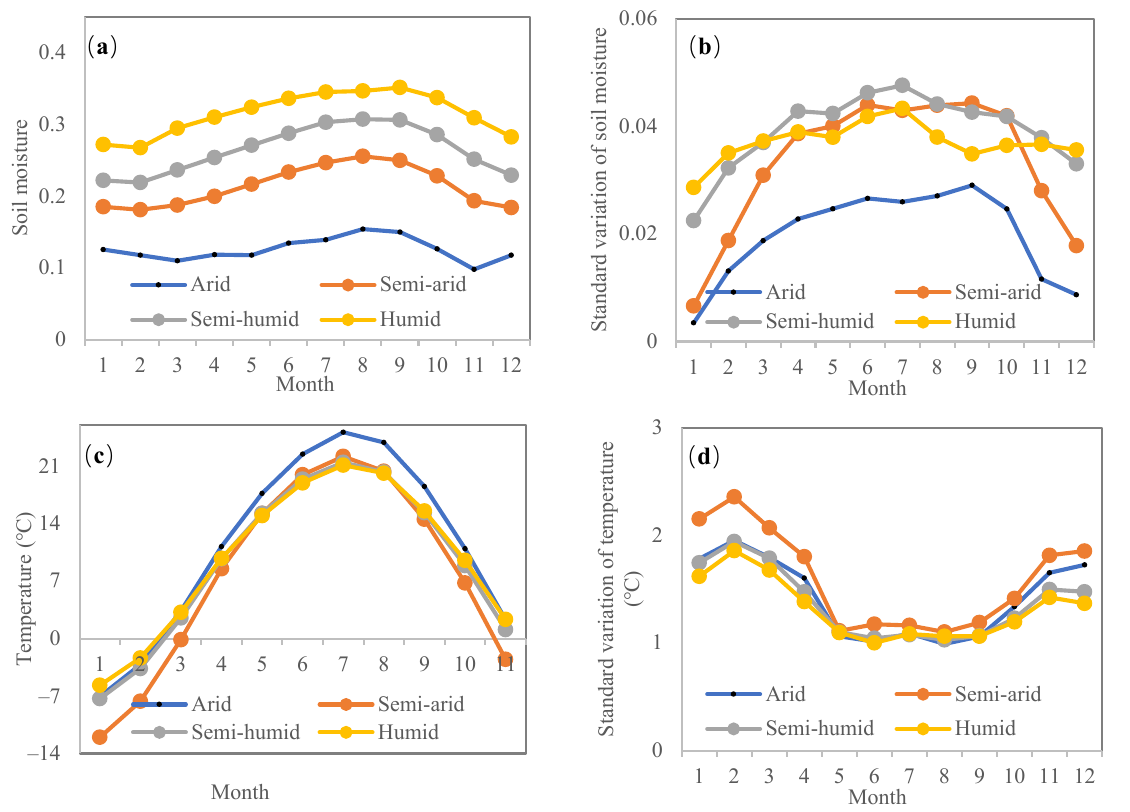
Figure 11. Intra-annual variation in ( a ) soil moisture, ( b ) standard deviation of soil moisture, ( c ) temperature, and ( d ) standard deviation of temperature (standard deviation of each month data for the 39 years) under different dry-wet climatic backgrounds.